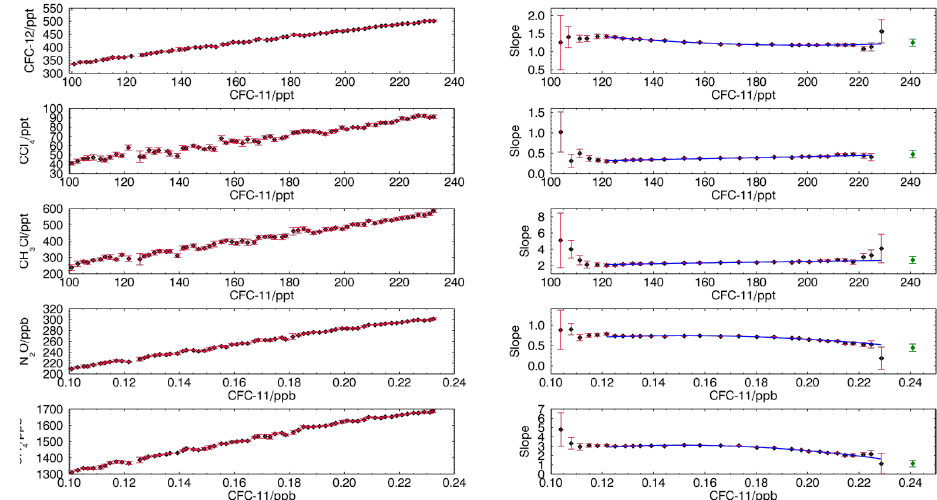
Figure B11 Correlations between the volume mixing ratios of CFC-12, CCl 4 , CH 4 , CH 3 Cl and N 2 O and CFC-11 for the data from the southern hemisphere during the stratospheric summer of 2006. Left panels: The mean correlation profile. Each point represents the mean of the VMR in a window of 2 ppt of CFC-11. The error on these points is the standard deviation of the data within each 2 ppt window. Right panels: The local slope of data in an 80 ppt of CFC-11 window. The error on the points is the fitting error of this fit. The blue line is a second degree polynomial fit to the local slopes. The green point is the extrapolated slope at the tropopause.